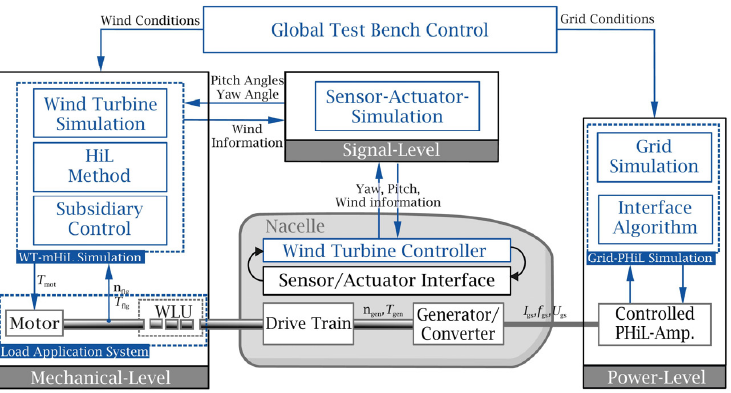
Figure 2. Schematic overview of a wind turbine test bench with multi-physics HiL functionality.